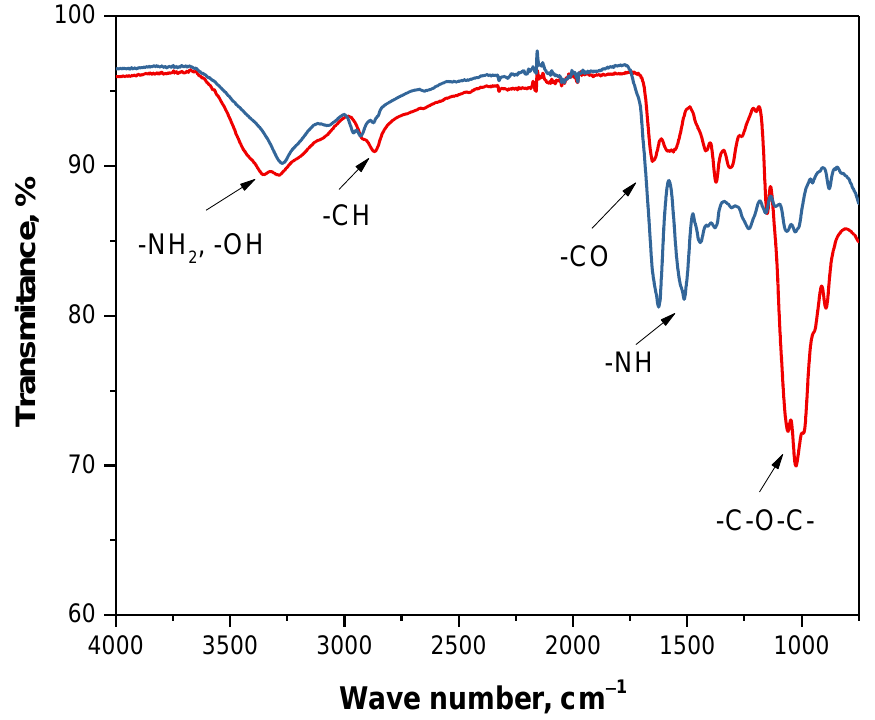
Figure 5. FT-IR spectra of commercial chitosan (red line) and selected sample after two-stage processing (blue line).